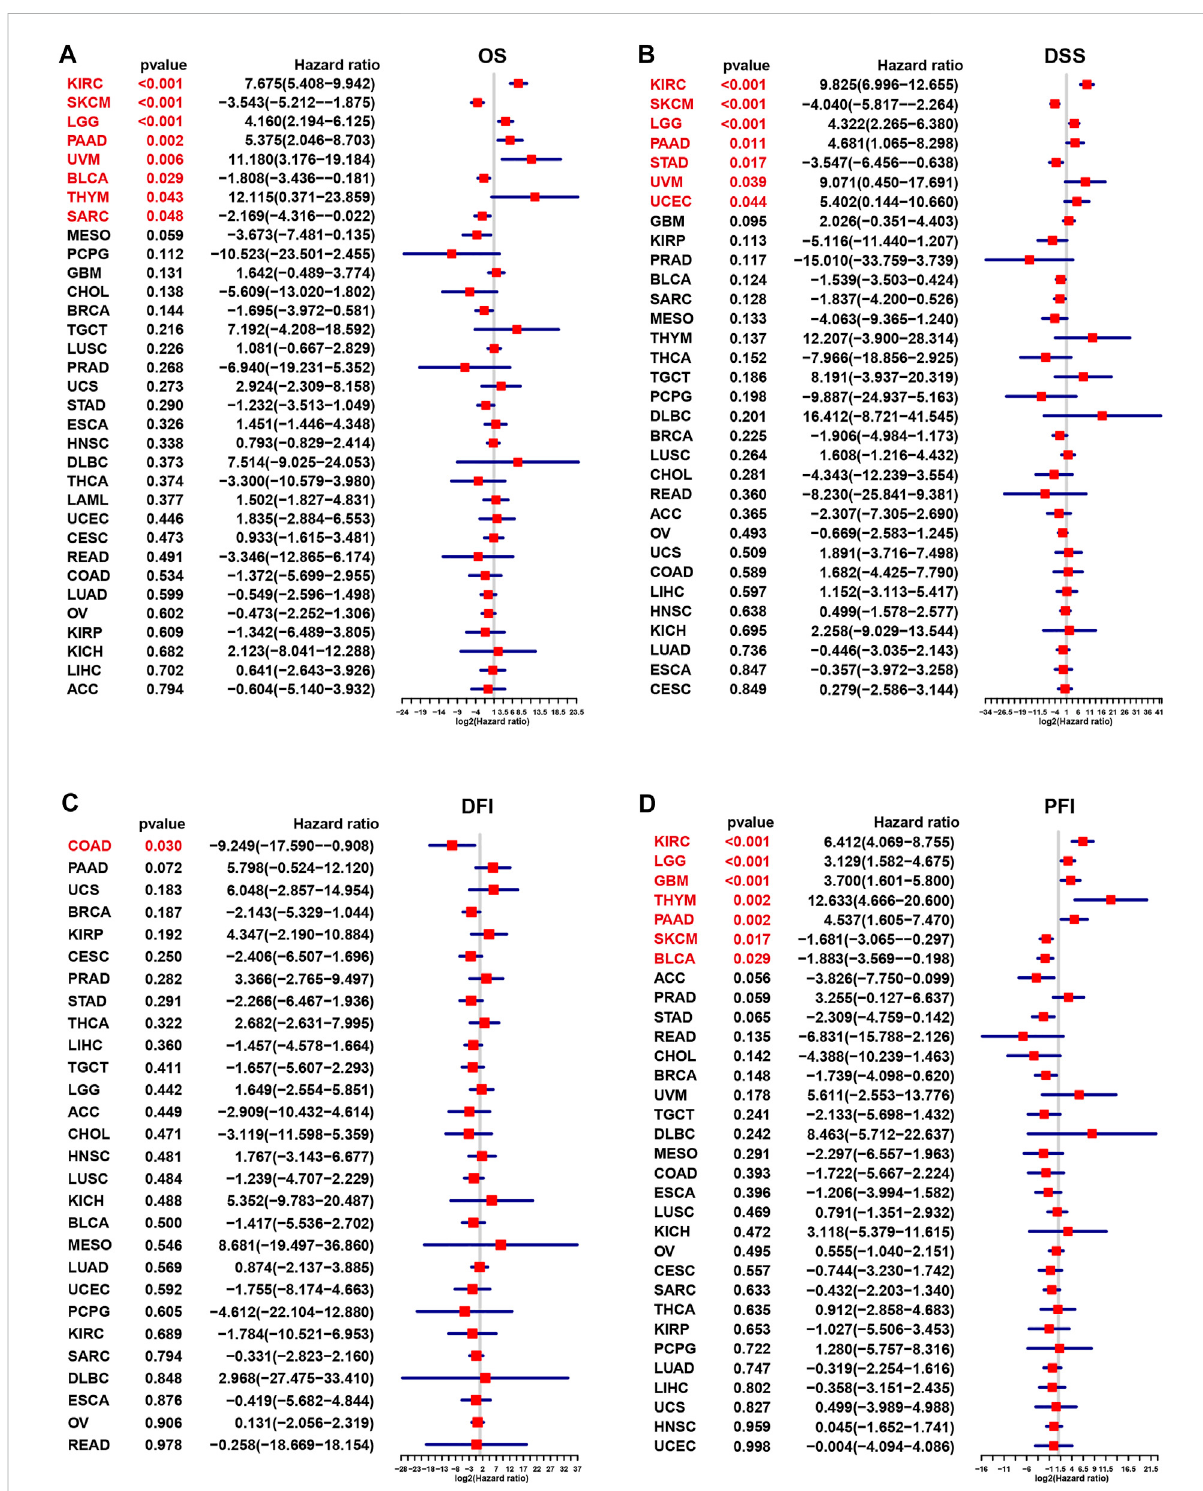
FIGURE 3 Correlation of m7G modi fi cation level with prognosis in each cancer based on Cox regression. (A) Overall survival. (B) Disease-speci fi c survival. (C) Progression-free interval. (D) Disease-free